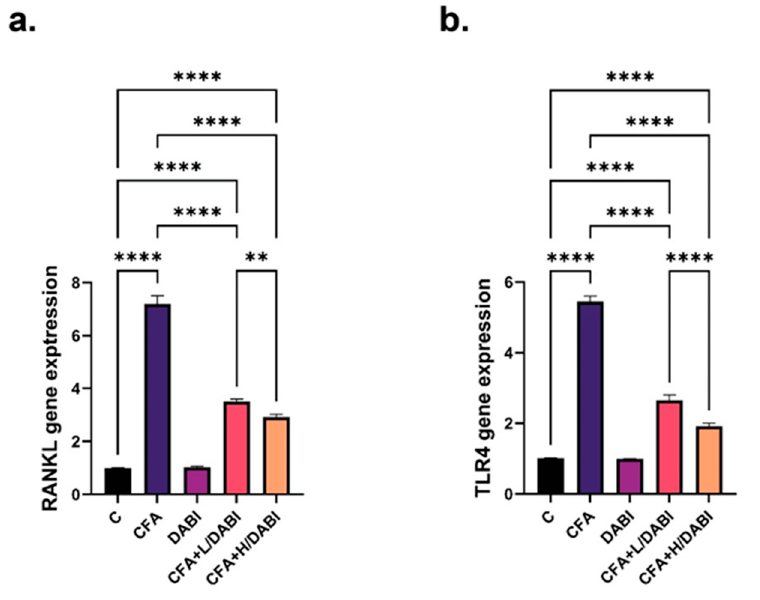
Figure 4. Effects of Dabigatran on RANKL and TLR4 expression. qPCR analysis of tissue RANKL ( a ), and TLR4 levels ( b ) in different groups as described in methods section. ** p ≤ 0.01; **** p ≤ 0.0001, ( n = 8).